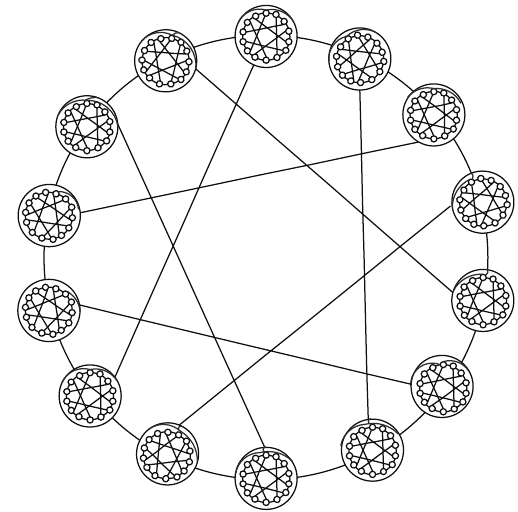
Figure 13: A 2-dimentinal RFH HIN [12].